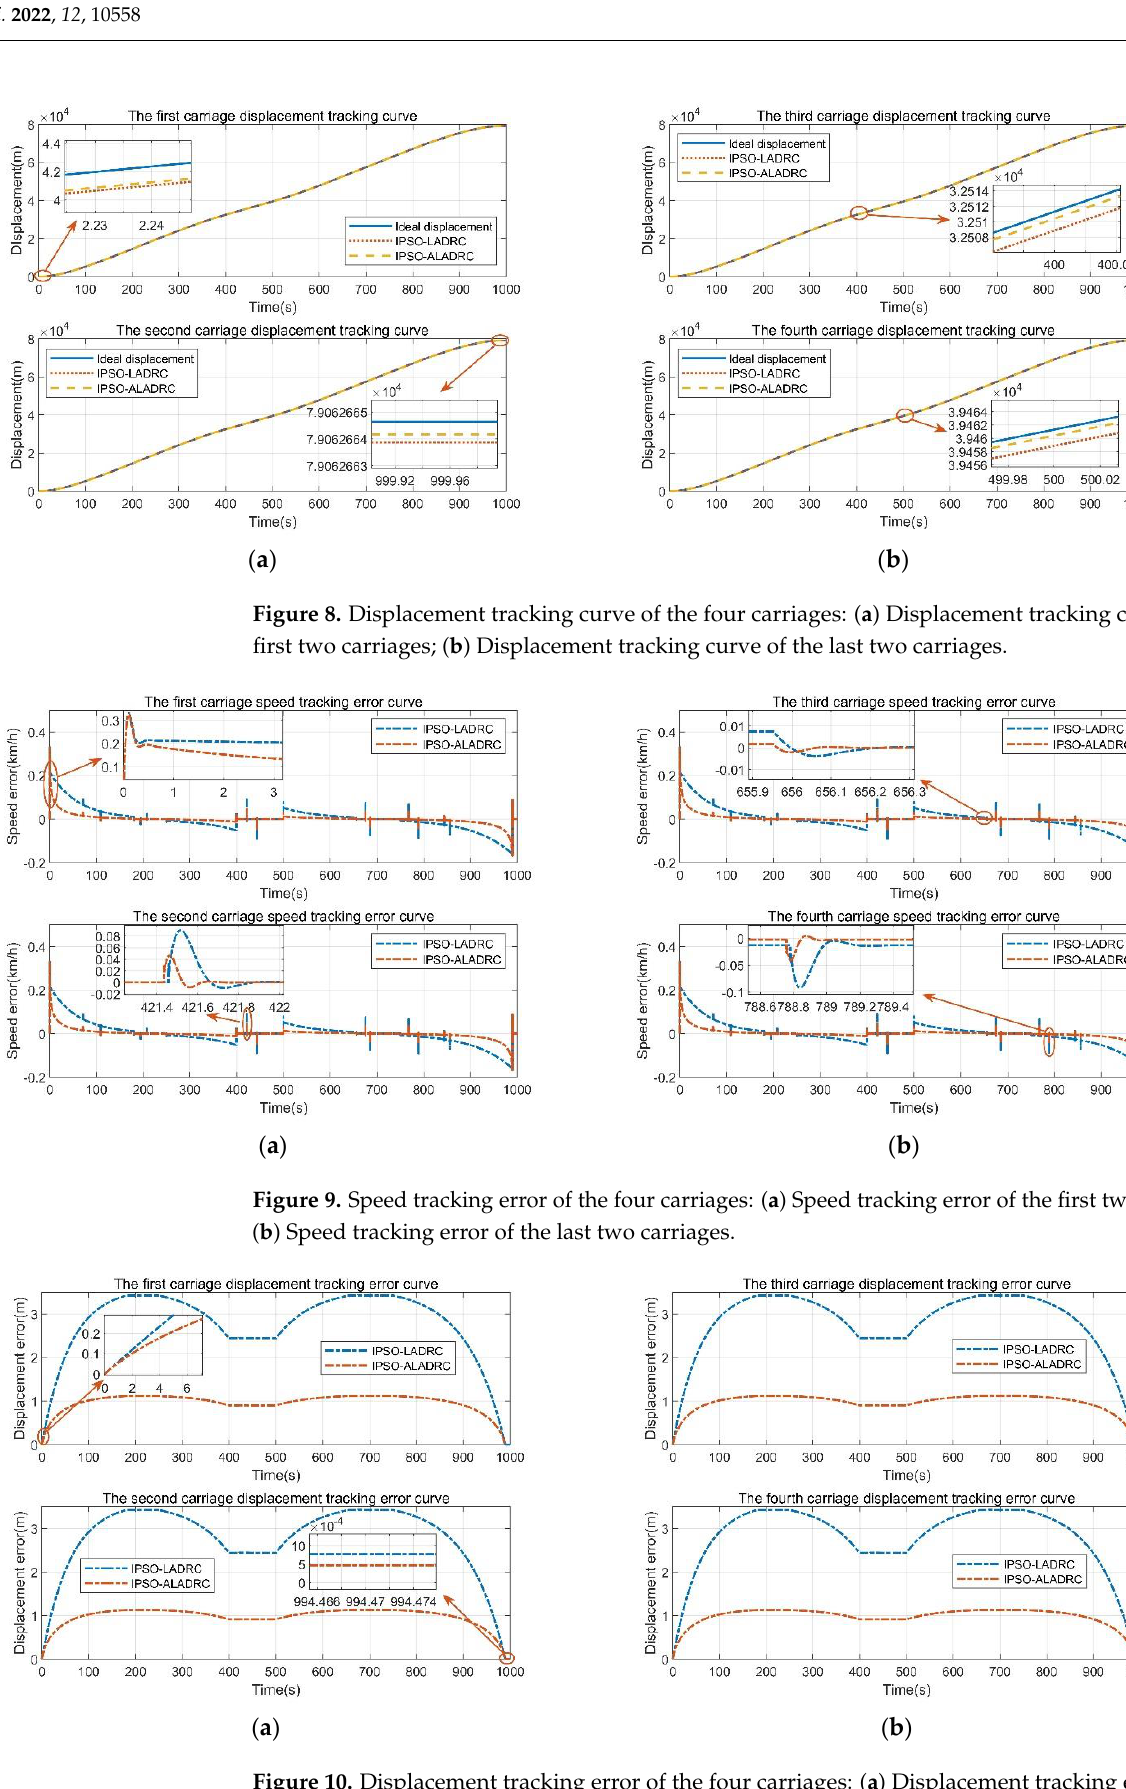
Figure 10. Displacement tracking error of the four carriages: ( a ) Displacement tracking error of the first two carriages; ( b ) Displacement tracking error of the last two carriages.